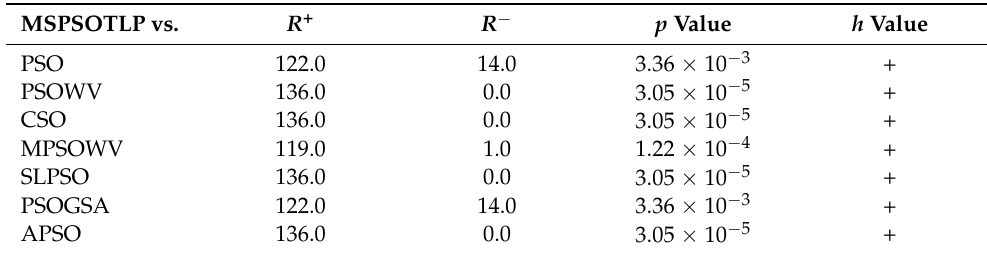
Table 13. Wilcoxon signed rank test as a pairwise comparison between the ANN models optimized by MSPSOTLP and each PSO variant when classifying the training samples. MSPSOTLP vs.